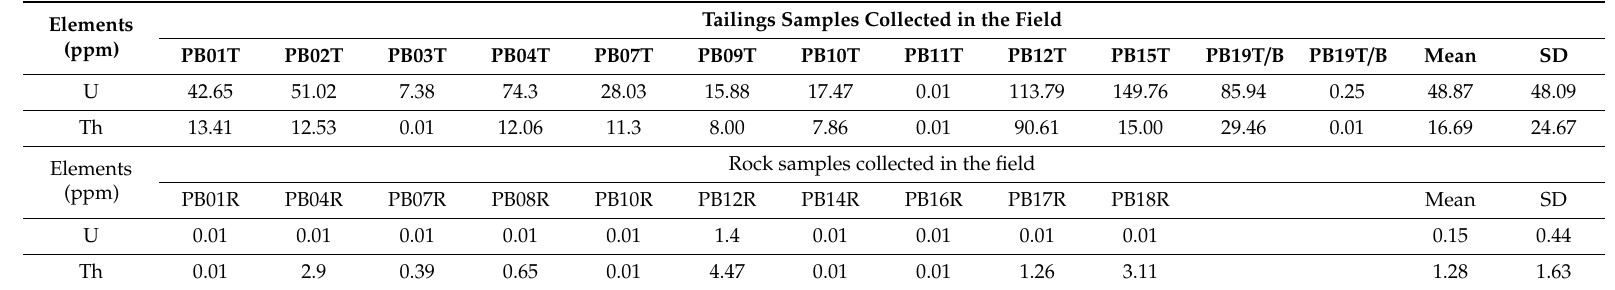
Table 1. Uranium and thorium concentration found in tailings and rock samples collected in the study area.